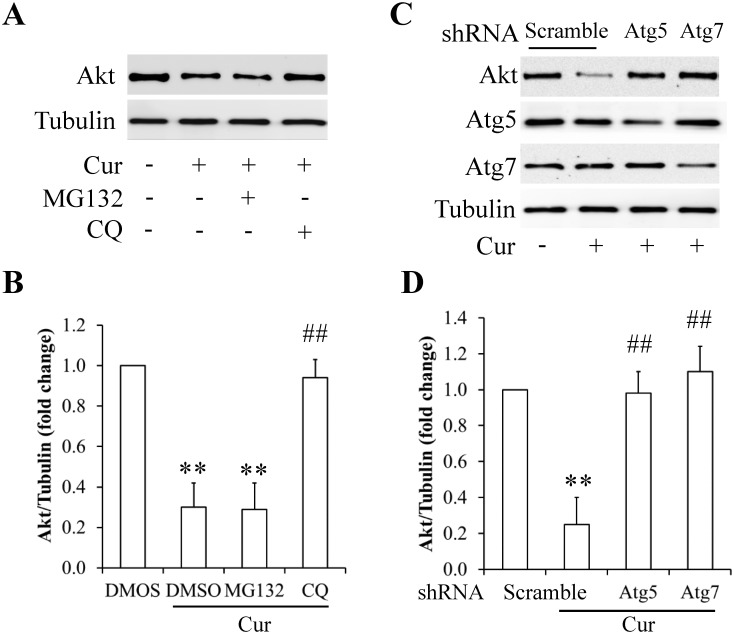
Effect of autophagy inhibition and UPS inhibition on curcumin-reduced Akt expression in MDA-MB-231 cells.(A) A representative western blot band of Akt in cells treated with proteasome inhibitor MG132 and autophagy inhibitor chloroquine (CQ). (B) Quantitative analysis of Akt levels in (A). (C) A representative western blot band of Akt in Atg5/7 knockdown cells. (D) Quantitative analysis of Akt levels in (C). Data are means ± SEM. (n = 4). ** p<0.01 vs DMSO control. ## p<0.01 vs curcumin-treated group.